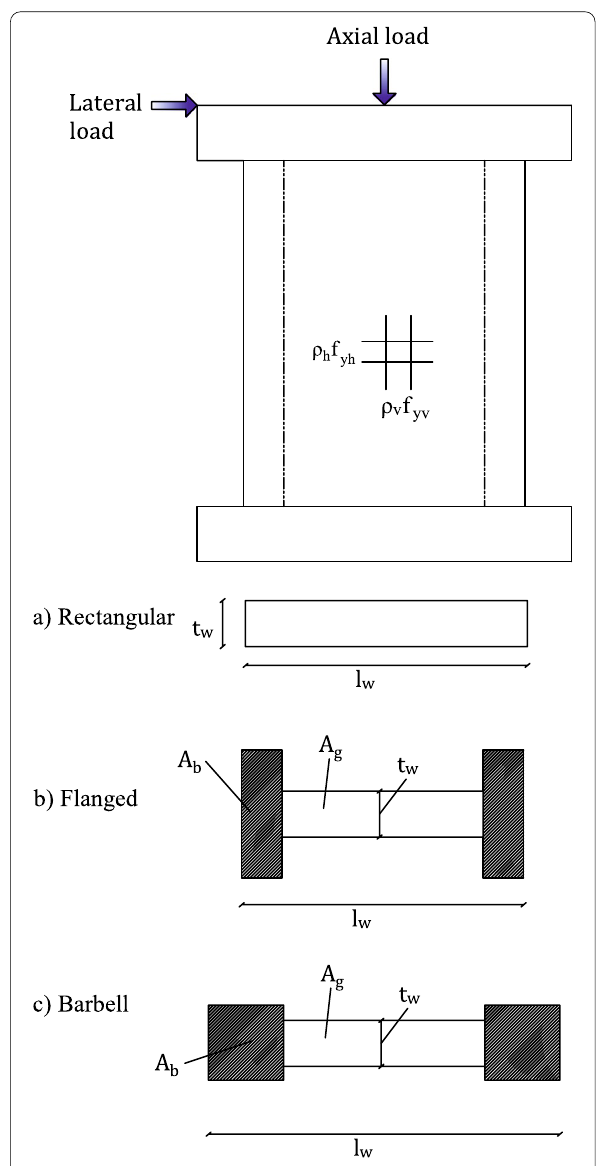
Fig. 1 Cross-sections of the reinforced concrete walls.